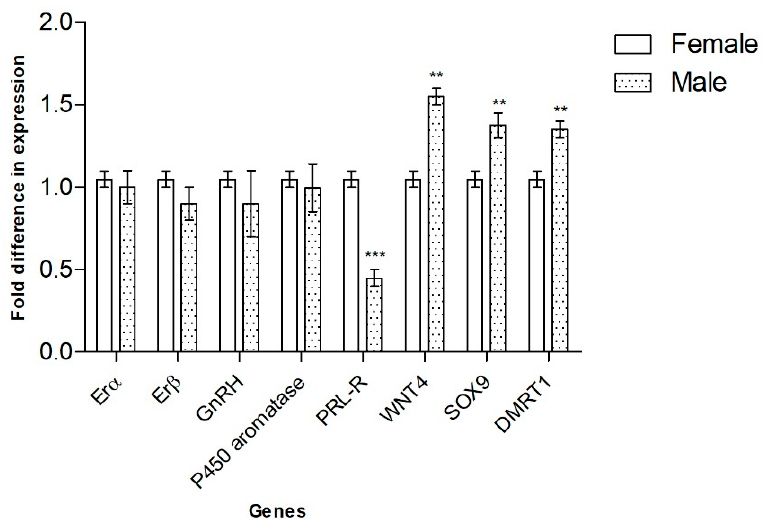
Figure 1. Expression analysis of genes canonically involved in sexual differentiation by qRT-PCR. mRNA levels of FPT embryos are related to MPT embryos. Data are presented as mean with SD. Statistical significance was determined using t -tests with Holm–Sidak correction for multiple comparison. ** p < 0.01, *** p < 0.001 .